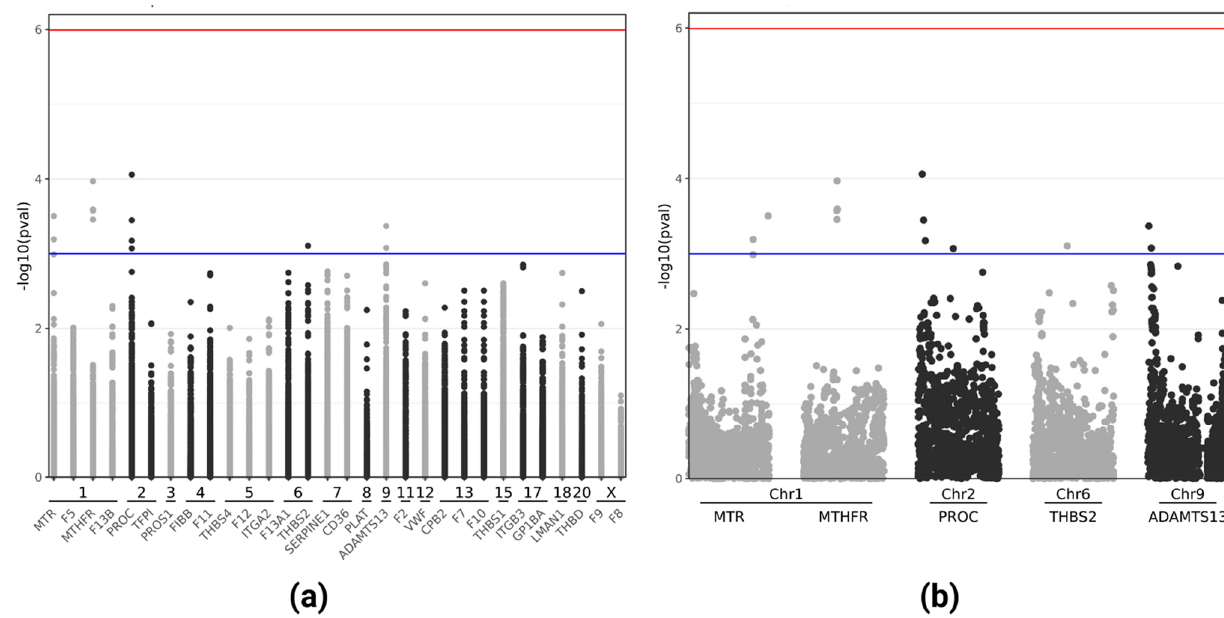
Figure 1. Manhattan plots for the analyzed regions. Manhattan plots summarizing the results of single-gene association analyses ( a ), with a close-up view relative to the top 5 genes ( b ). The horizontal lines represent the suggestive p = 0.001 (blue) and the Bonferroni-corrected p = 1.02 × 10 − 6 (red) significance levels. Genomic regions belonging to the same chromosome are all represented with the same color (either gray or black). Plots were produced using R.